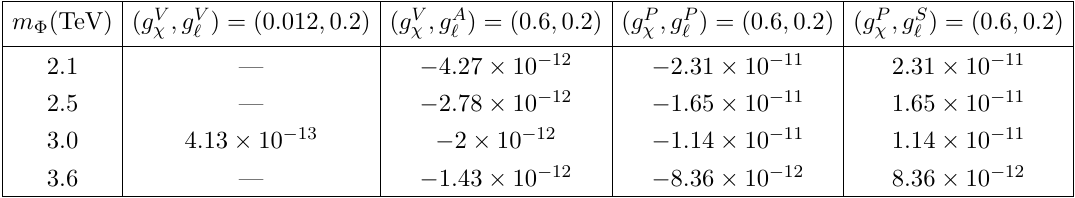
Table 3 . Same as table 2, but for the corrections to the anomalous magnetic moment of the muon (cid:1) a (cid:22)